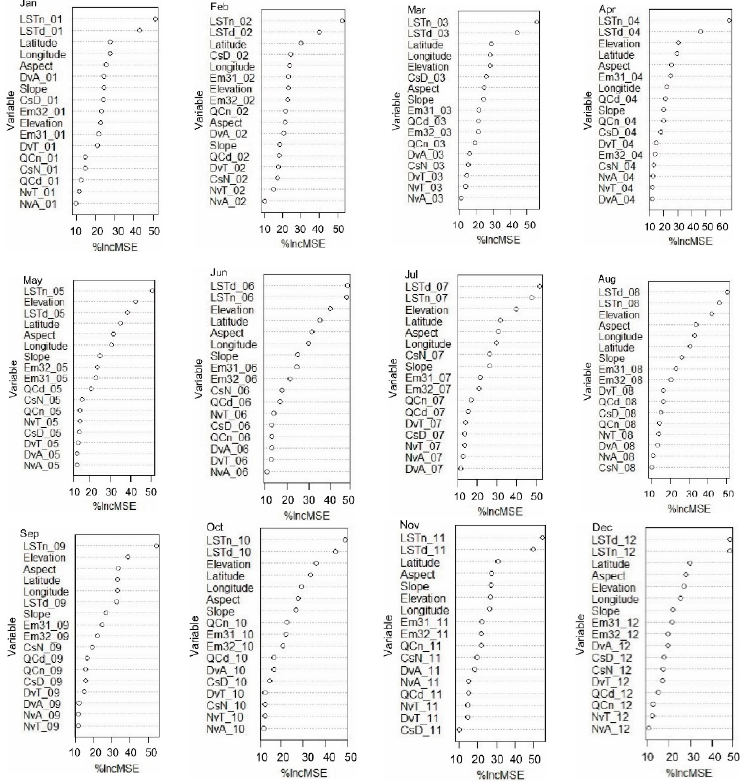
Figure 5. Random forest (RF) variable importance for each month. The importance is here given as the percentage increase in mean square error